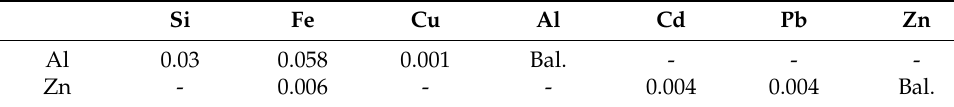
Table 1. Chemical composition of aluminum and zinc powder